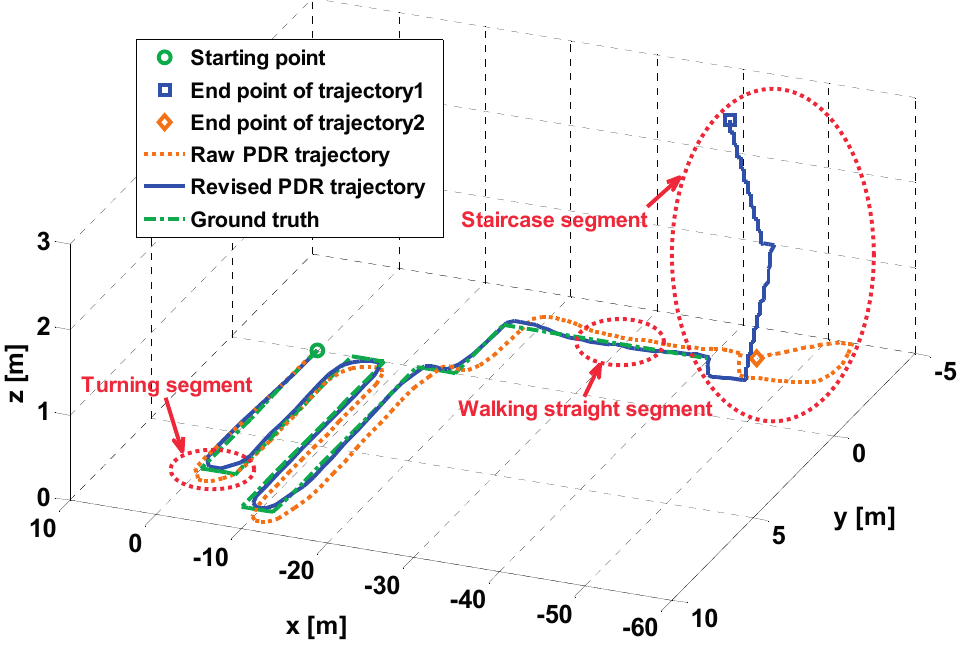
Figure 9. Illustration of proposed adaptive step length estimation for revising a pedestrian’s trajectory in PDR